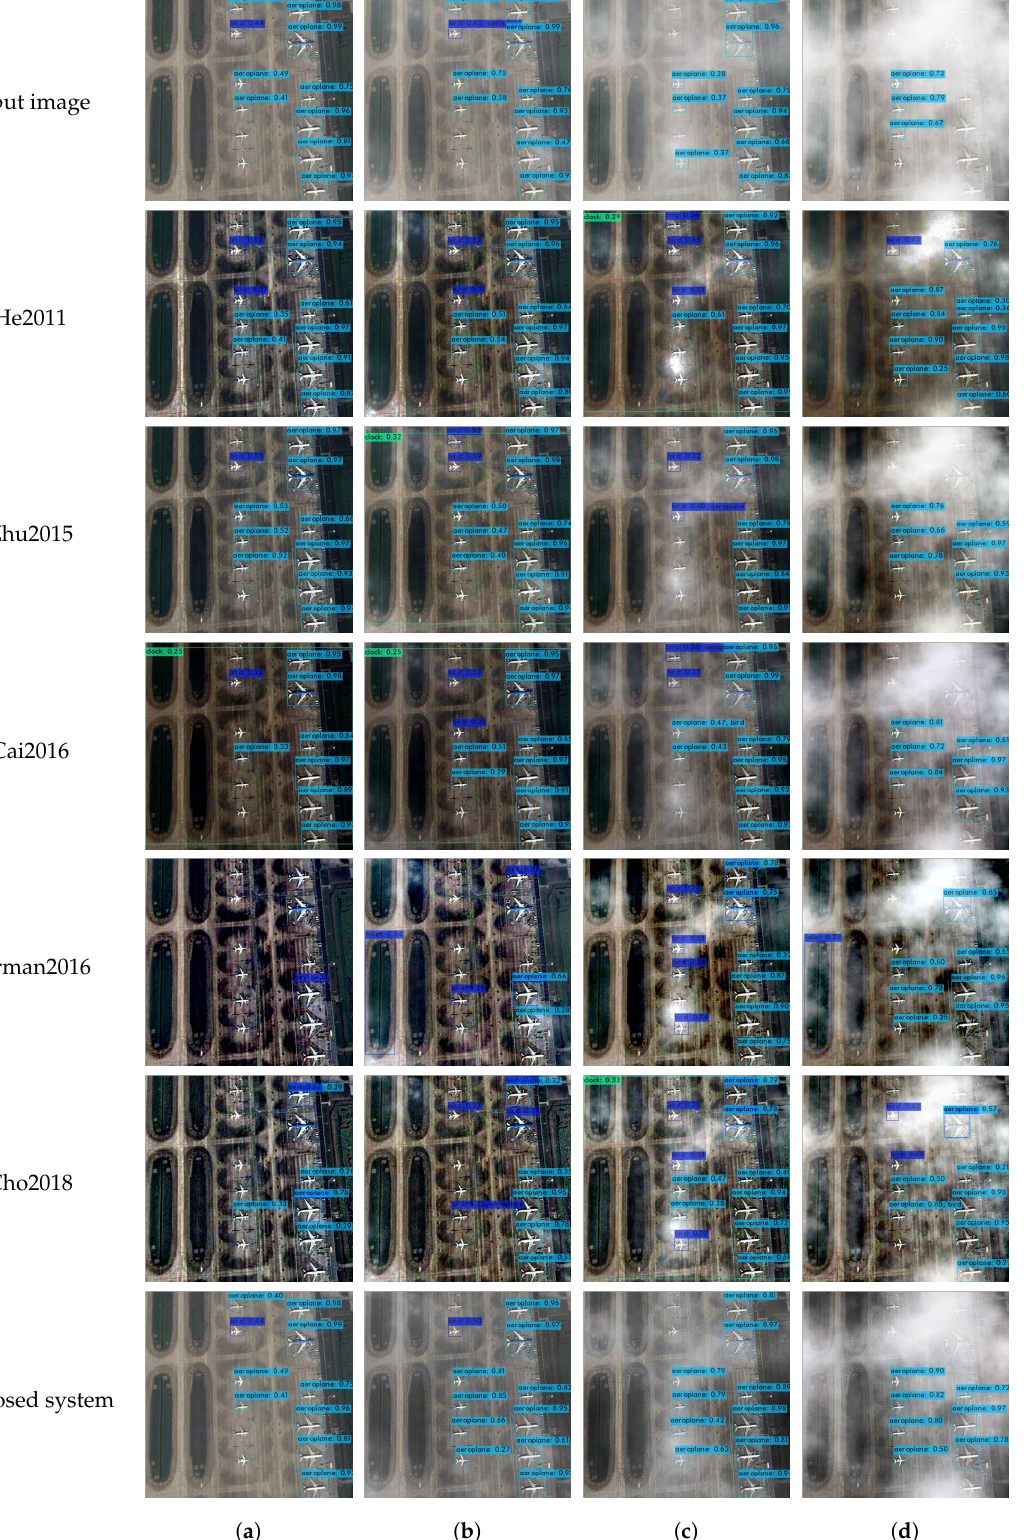
Figure 11. Detection results for a YOLOv4-based high-level object recognition algorithm operating on images in Figure 9. ( a – d ) correspond to four haze conditions: haze-free, thin, moderate, and dense. The ρ I values of input images are 0.8771, 0.9026, 0.9279, and 0.9594, respectively. He2011, Zhu2015, Cai2016, Berman2016, and Cho2018 denote five benchmark methods of He et al. [9], Zhu et al. [11], Cai et al. [13], Berman et al. [12], and Cho et al. [2]. Notes: cyan labels represent airplanes, navy-blue labels represent birds, and green labels represent